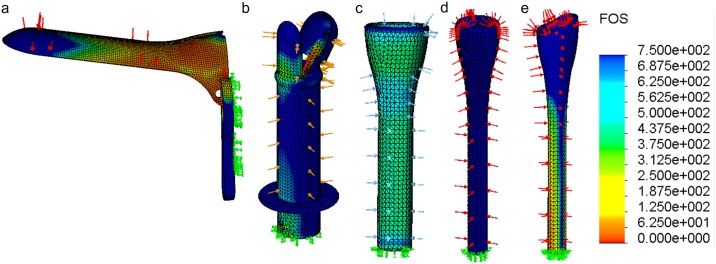
Finite element analysis and factor of safety (FOS) plots for the standard speculum and the inserter/expander prototypes.Green arrows indicate fixed surfaces and other colored arrows indicate applied pressure. All the prototypes designed have minimum FOS greater than 4 with the minimum factor of safety for the devices as follows: a) speculum = 8.07, b) billed expander = 11.67, c) silicone expander = 346, d) flat tip inserter = 3095 and e) the curved tip inserter = 90.9.